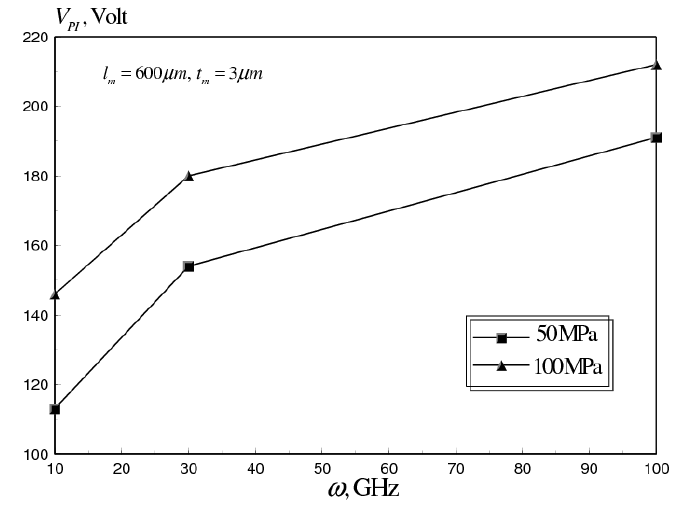
Figure 11. Effect of microfabrication mean residual stresses on V MEMS switch at operating frequency range of 10-100 GHz ( l t = 3 µm m